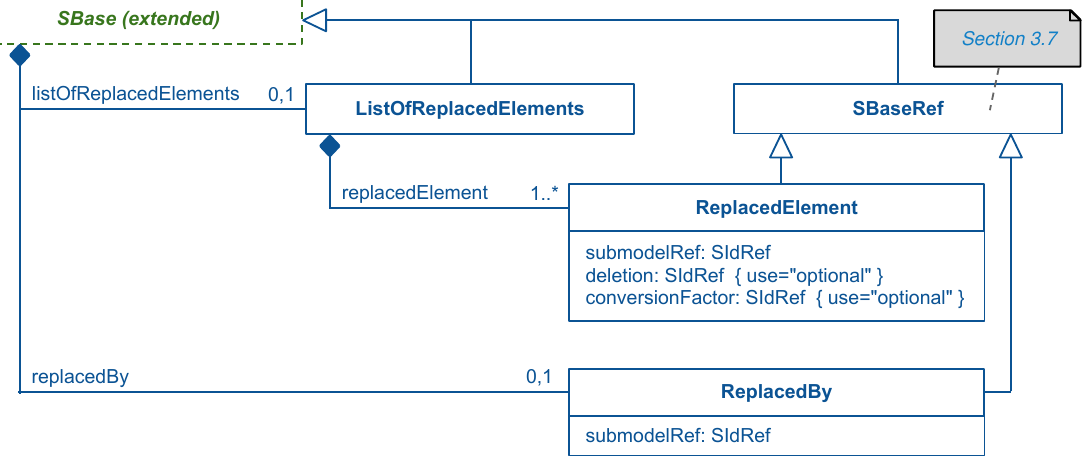
Figure 6: The extension of SBase and the definition of the ListOfReplacedElements and ReplacedElement classes. The SBaseRef class is defined in Section 3.7 on page